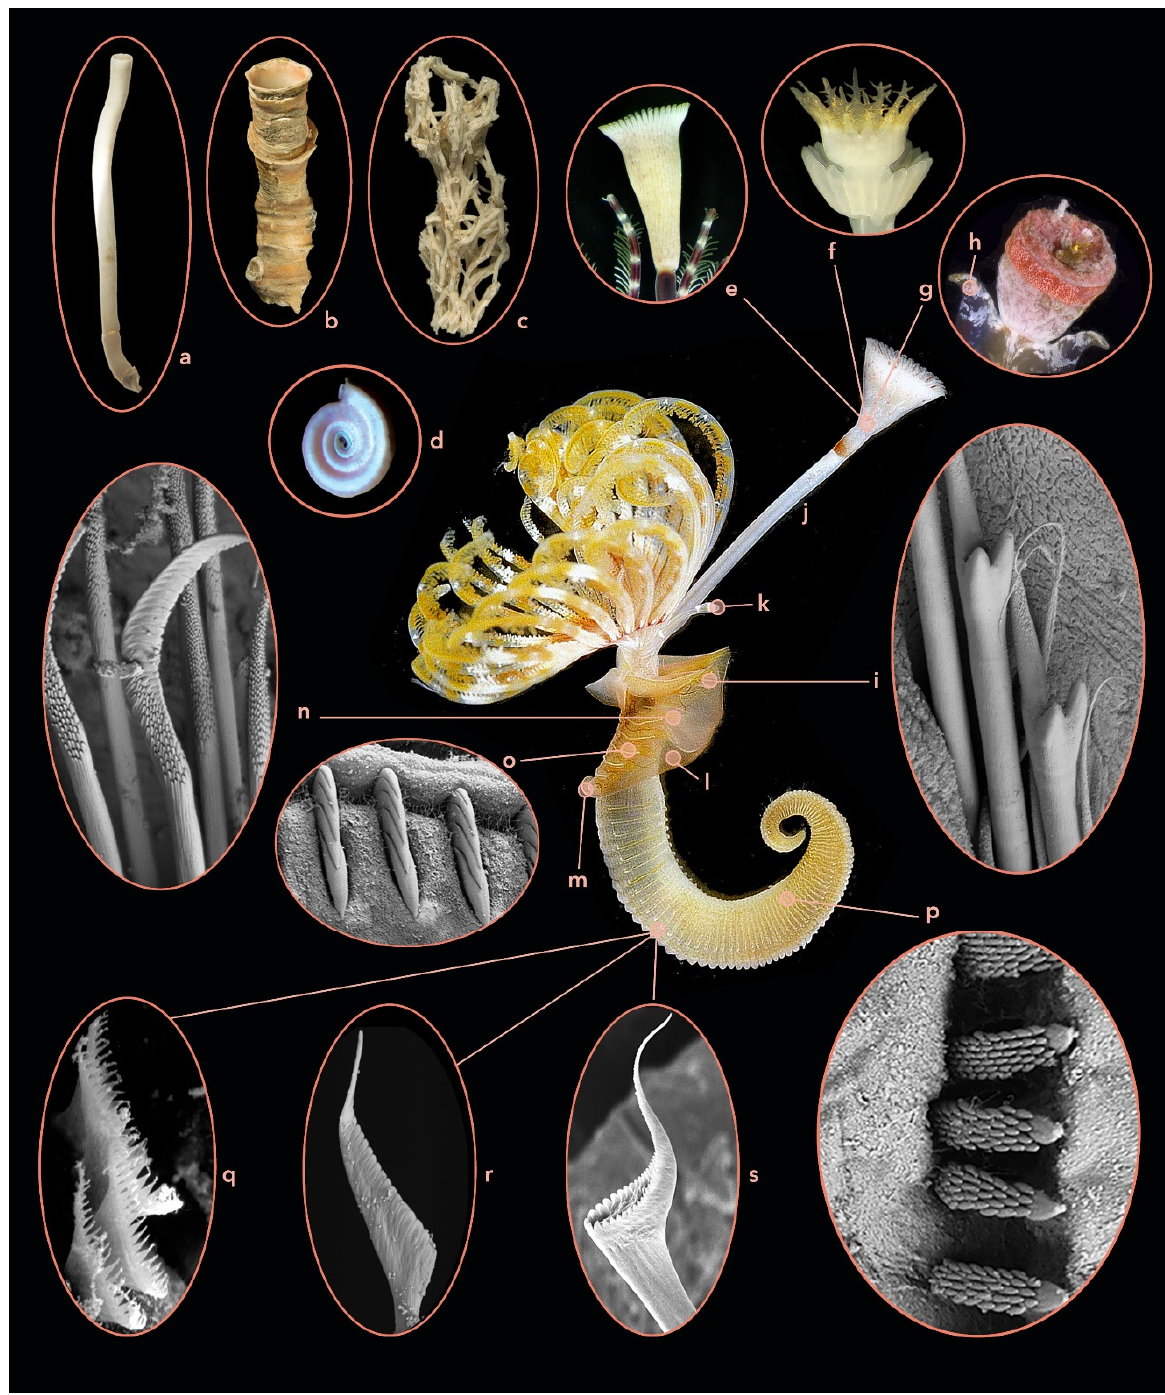
Figure 10. Main diagnostic characters for members of Serpulidae. Centre: lateral view of a Serpula specimen removed from the tube; ( a – d ) Tubes: Hyalopomatus biformis ( a ), Serpula vermicularis ( b ), Filograna implexa ( c ), Circeis armoricana ( d ); ( e – h ) Opercula: Serpula ( e ), Hydroides ( f ), Spirobranchus ( g ) showing distal wings ( h ); ( i ) Special (bayonet) collar chaetae of Hydroides ; ( j ) Peduncle; ( k ) Pseudoperculum; ( l ) Thoracic membranes; ( m ) Apron; ( n ) Thoracic Apomatus (sickle-shaped) chaetae of Vermiliopsis ; ( o ) Thoracic saw-shaped uncini of Hydroides ; ( p ) Posterior abdominal rasp-shaped uncini of Hydroides ; ( q – s ) Abdominal chaetae: flat trumpet-shaped of Serpula; ( q ), flat geniculate of Vermiliopsis; ( r ) true trumpet-shaped of Spirobranchus ( s ). ( a – c,f by E. Wong, d by A. Rzhavsky, e by G. Rouse, g , h by A. Semenov, j – m (central photo of Serpula ) by F. Verbiest, n – s (SEM images) by S. Lindsay).